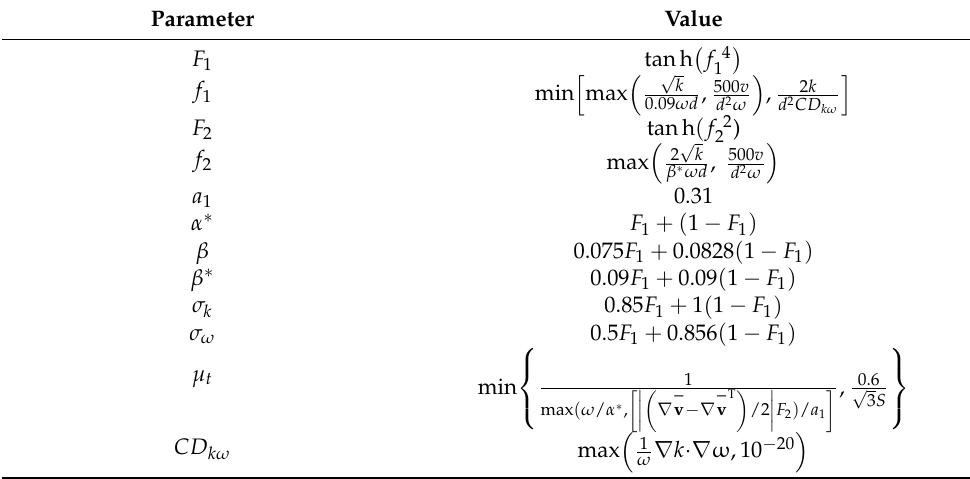
Table A1. Model constants used in SST k– ω model. Parameter Value F